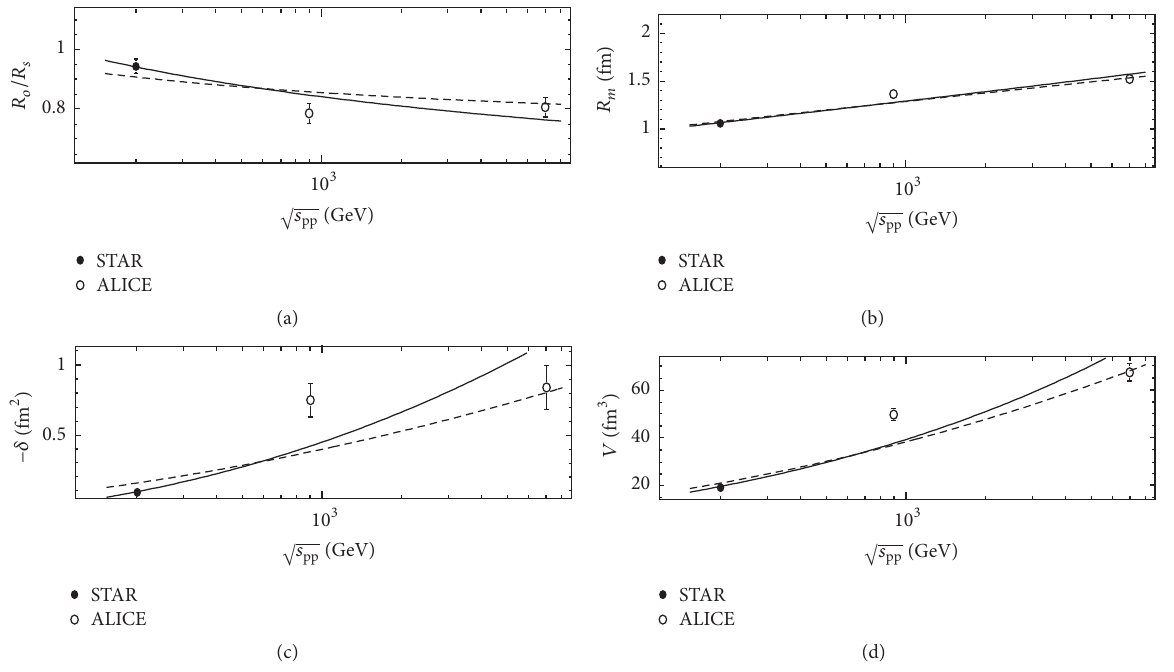
𝑗 , 𝑗 = 1 – 4 , for 𝑝 + 𝑝 collisions at midrapidity and low ⟨𝑘 2